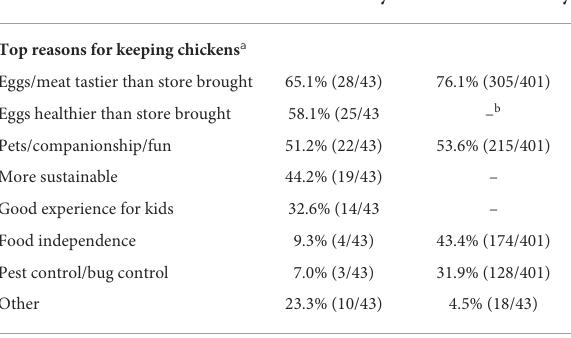
TABLE 2 Owner’s motivations for keeping poultry. TABLE 3 Backyard chicken owners’ biosecurity habits and knowledge of Salmonella